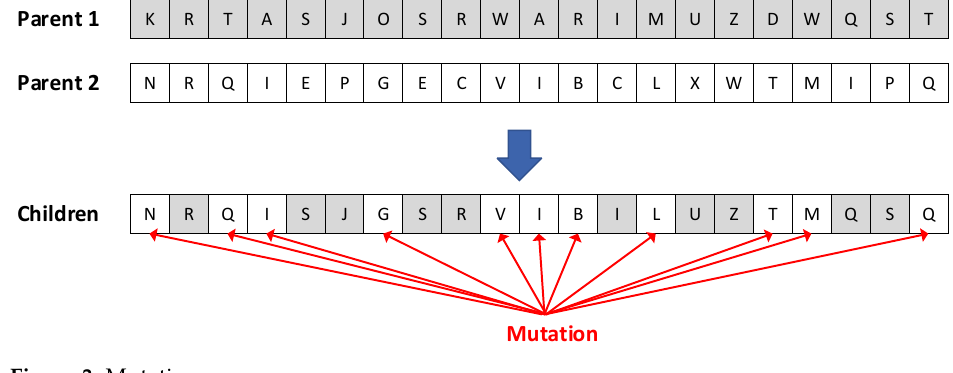
Figure 3. Figure 3. Mutation.